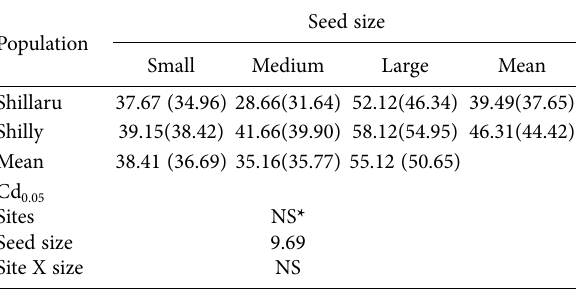
Table 9. Percentage of seed with embryo amongst different seed size classes in A. glauca.